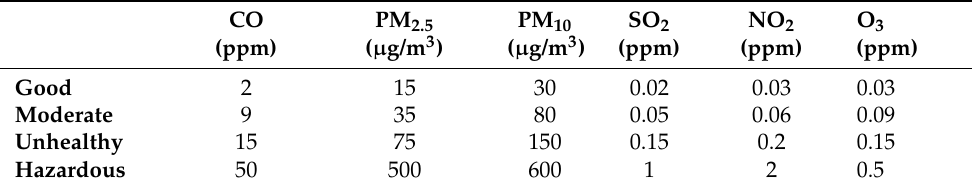
Table 1. Summary of air pollutant standards and classification.